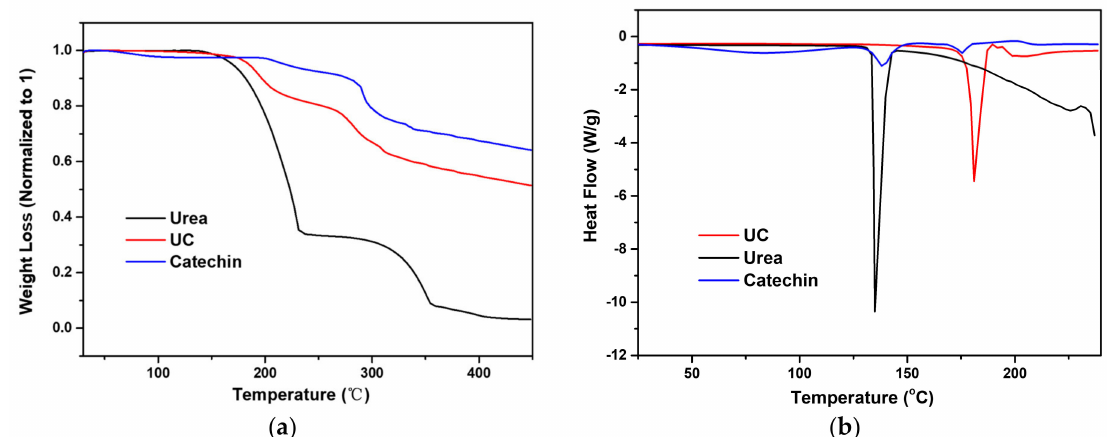
Figure 4. ( a ) TGA curves of urea, catechin and UC. ( b ) DSC curves of urea, catechin and UC.